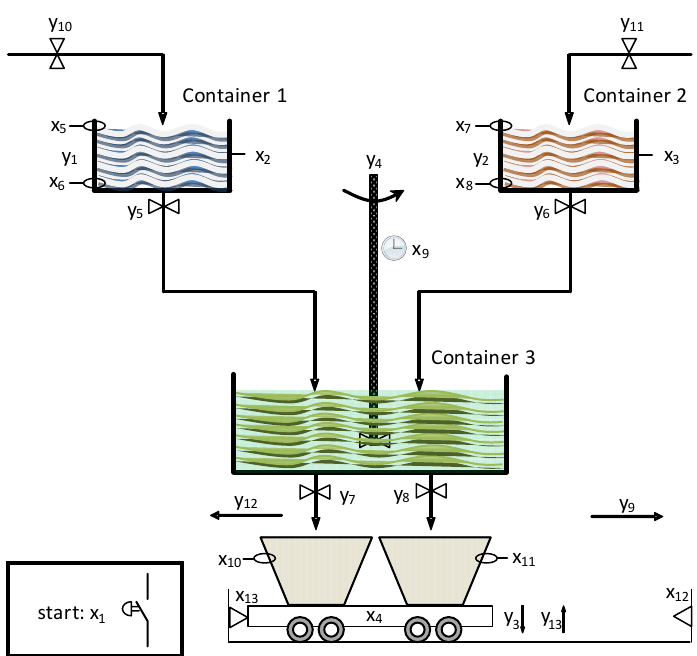
Figure 4. A beverage production and distribution system.